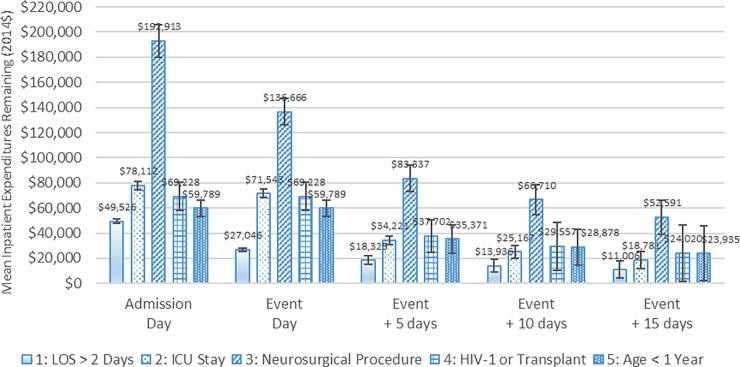
Mean inpatient healthcare expenditures remaining after the subgroup-defining event day for patients with meningitis, 2010 to 2014.Notes: The first 90 days and the last 90 days are excluded from the 2010 to 2014 period. For patients in Subgroup 4 (HIV-1 or Transplant) and Subgroup 5 (Age < 1 year), the subgroup-defining event day is the same as the initial hospital admission day because these patients could be classified into these subgroups upon admission. The values reported in the figure are the estimated means, and the error bars indicate the 95% confidence intervals of those estimates. Source: Authors’ analysis of 2010 to 2014 Truven Health MarketScan Commercial Claims and Encounters Database.